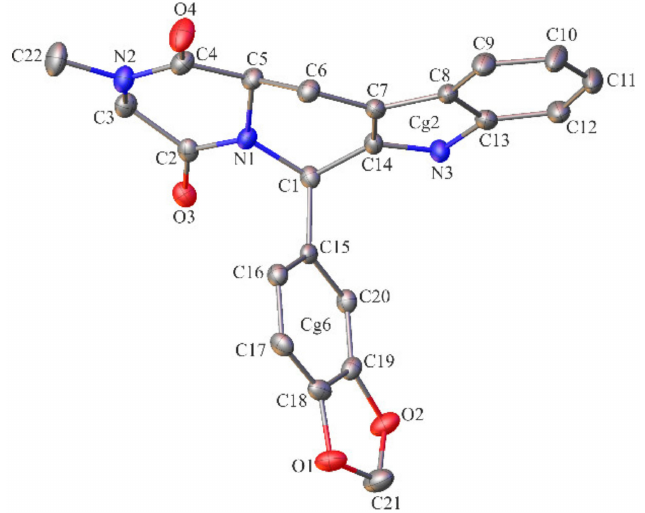
Figure 8. Asymmetric unit of the crystal lattice 1 with crystallographic numbering. Displacement ellipsoids are drawn at the 50% probability level and the H-atoms were omitted for clarity. Cg 2 and Cg 6 denote the geometric centres of gravity of the aromatic rings delineated by the N3/C13/C8– C7/C14 and C15–C20 atoms,